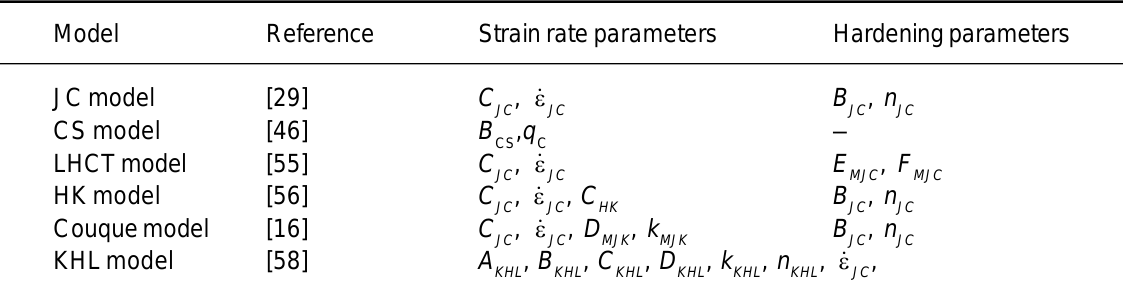
Table 3. Empirical models based on original Johnson-Cook